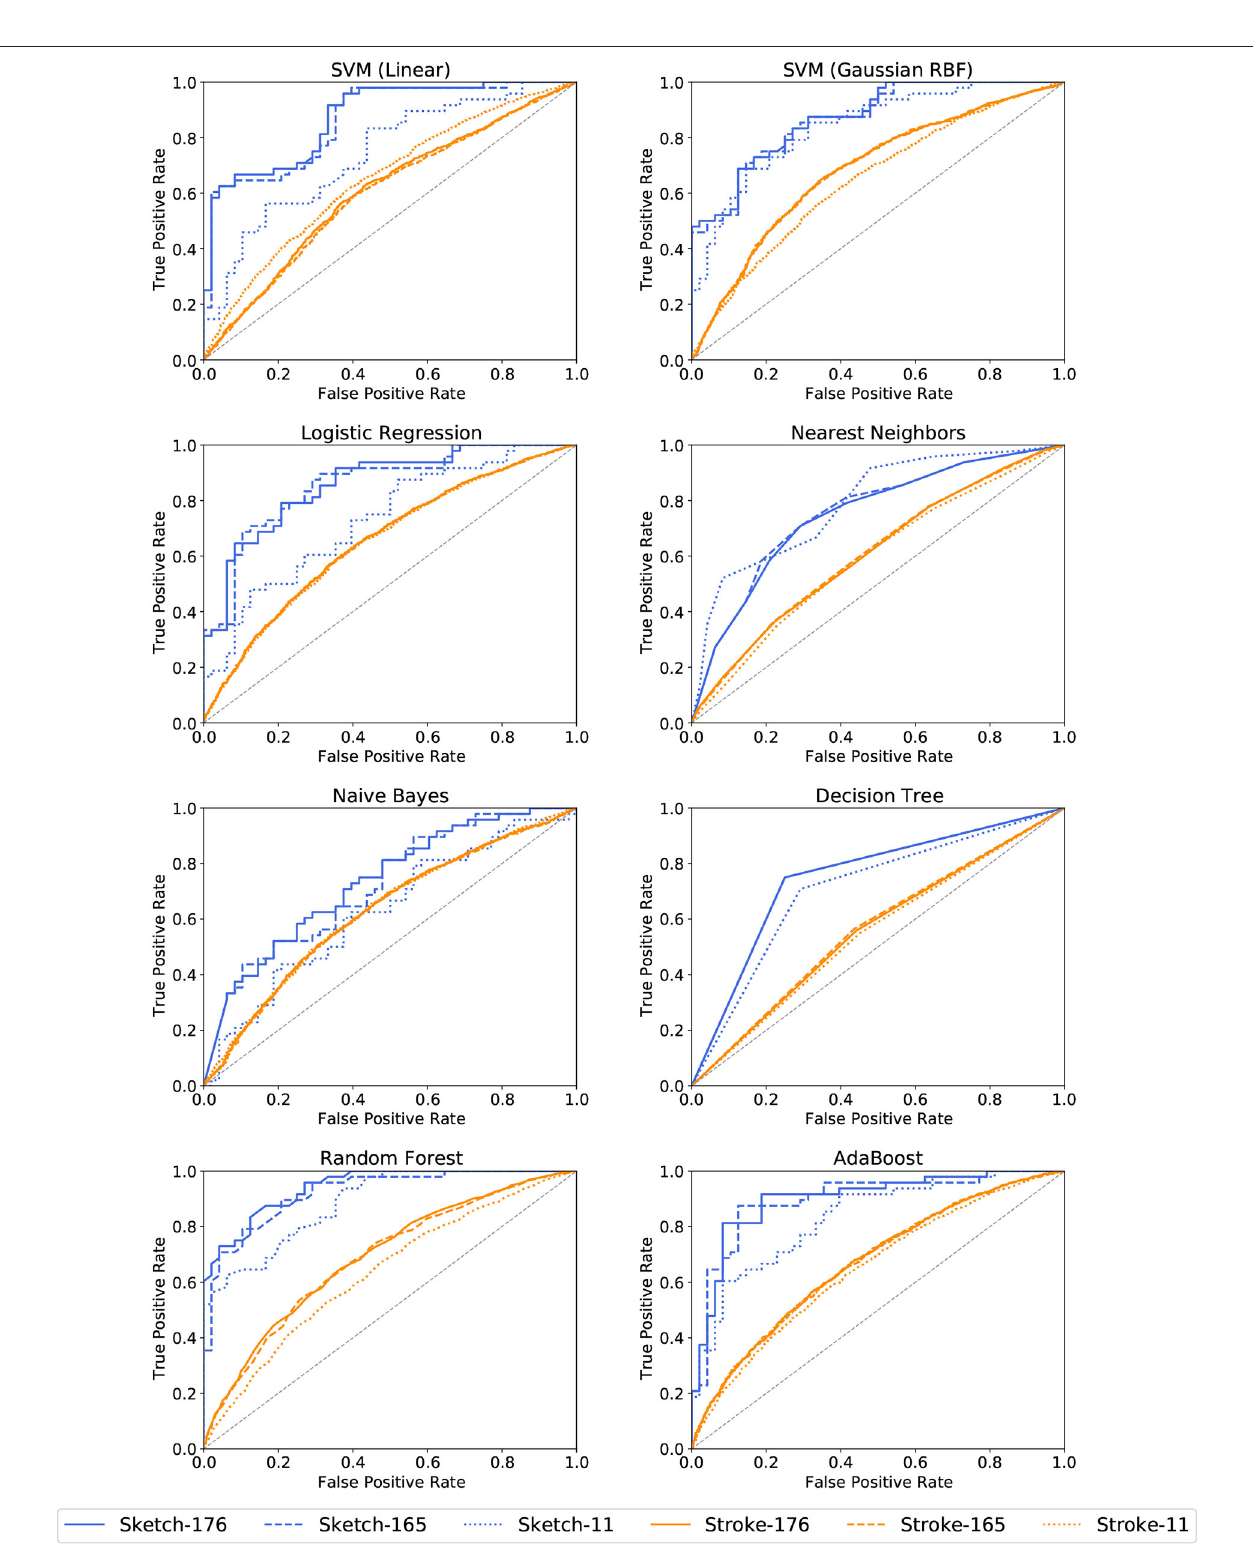
FIGURE 8 | ROC curves for cognitive test performance classification per ML method and feature subset. The jagged curves are a result of the binary classification.